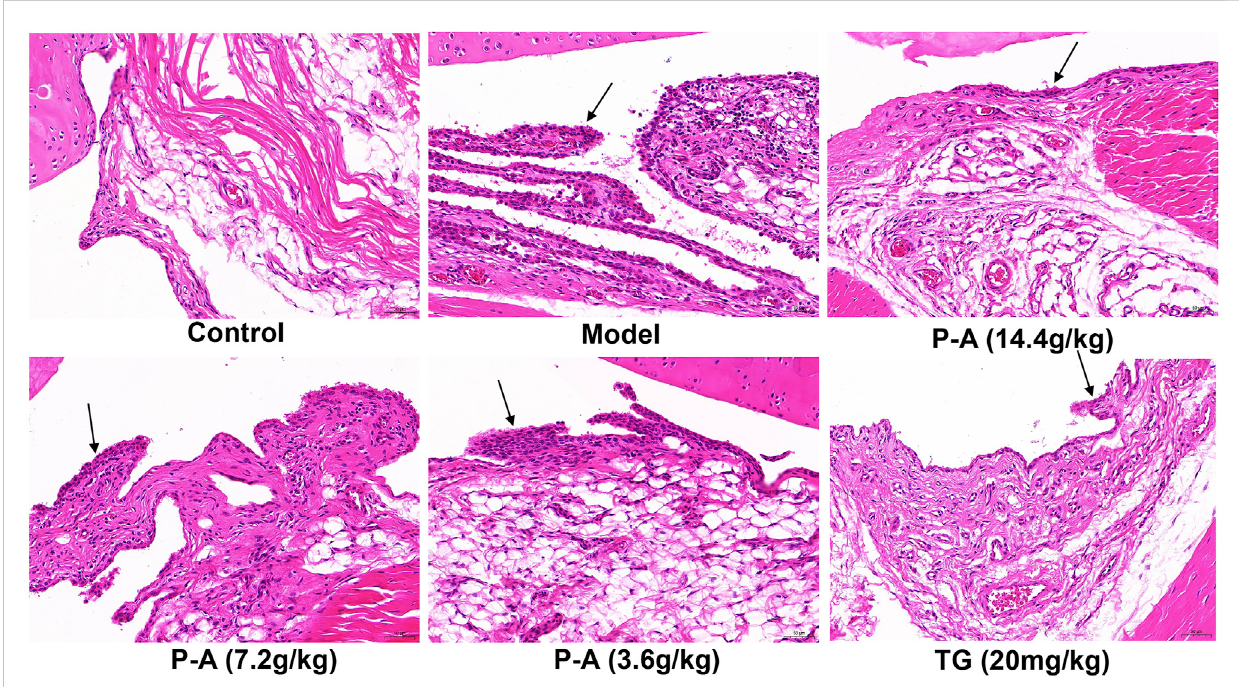
FIGURE 8 EffectoftheP-Adrug paironpathologicalchangesinthesynovium oftheanklejointinrats(HE, x200).Blackarrowrepresentssynovial hyperplasia.